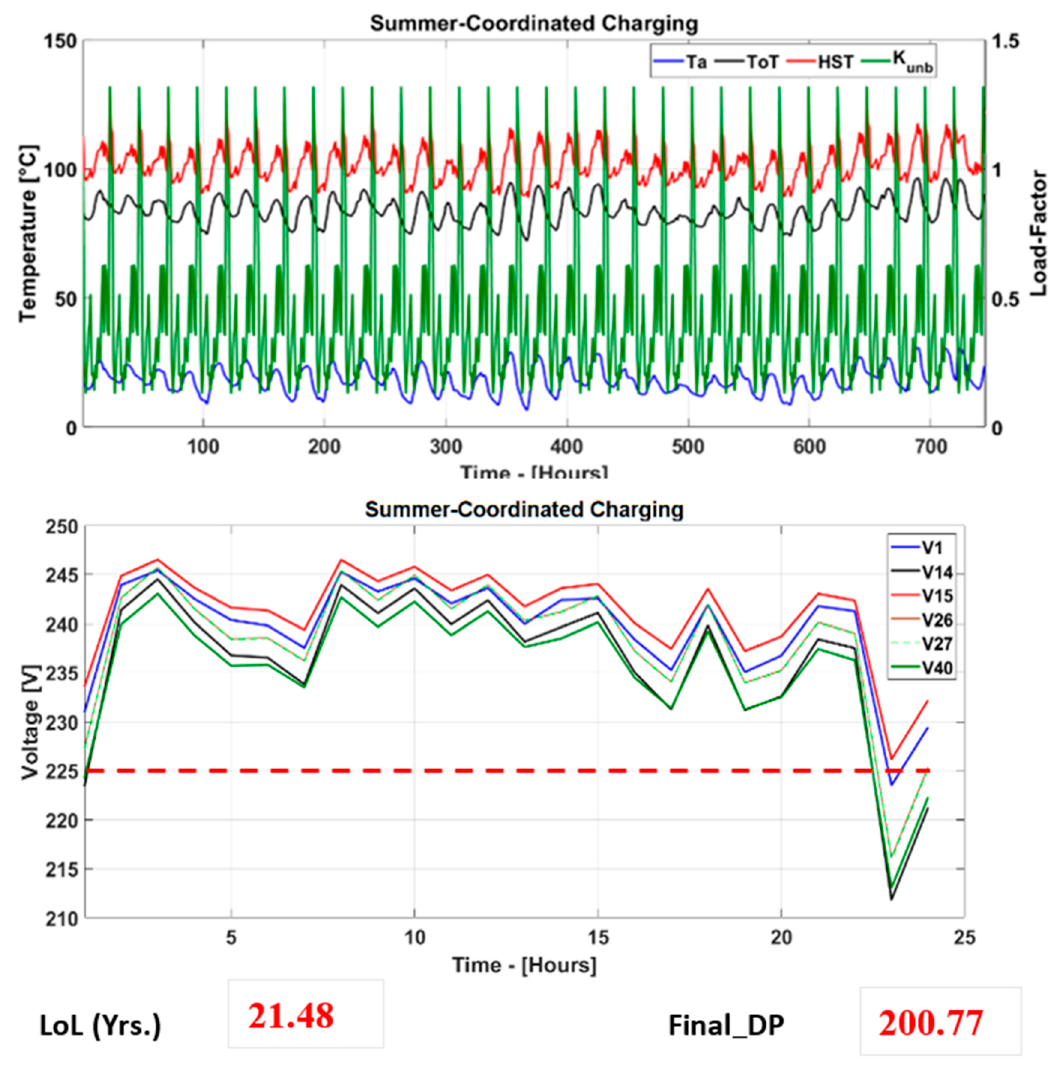
Figure 9. Output under coordinated charging across selected households, during summer, without Figure9. Outputundercoordinatedchargingacrossselectedhouseholds, duringsummer, withoutBESS. BESS. b. With